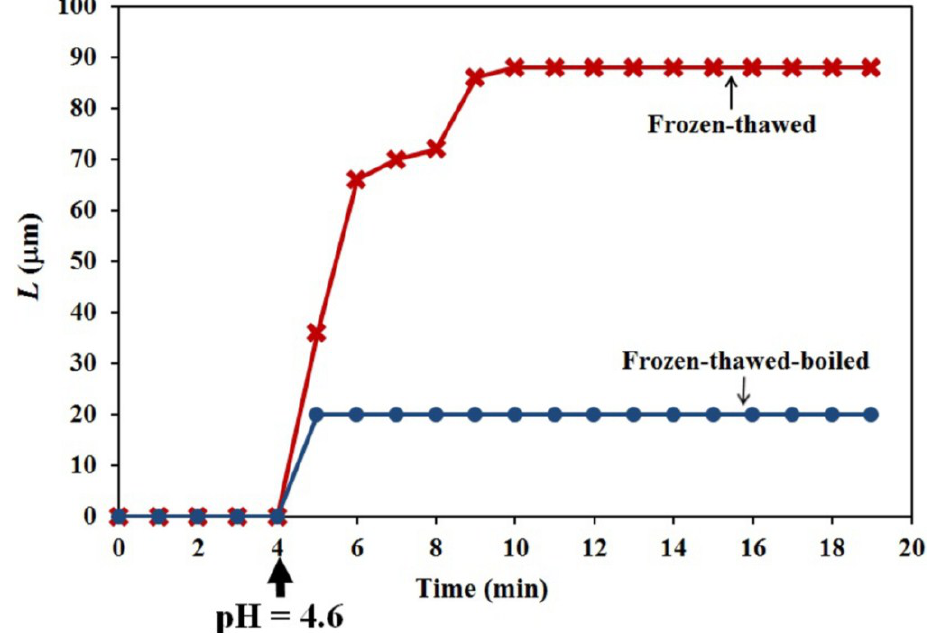
Figure 6. Extension behavior of two 5 mm-long sections from two different Stage IV sporangiophores that were frozen and then thawed is shown. Each wall section includes the growth zone of a Stage IV sporangiophore. The red curve with X data points and labeled “Frozen-thawed” shows the extension behavior of a frozen-thawed wall before and after the pH of the bathing solution was reduced from 7.0 to 4.6. The blue curve with • data points and labeled “Frozen-thawed-boiled” shows the extension behavior of a frozen-thawed wall that was boiled in water for 15 s before being subjected to the same experimental